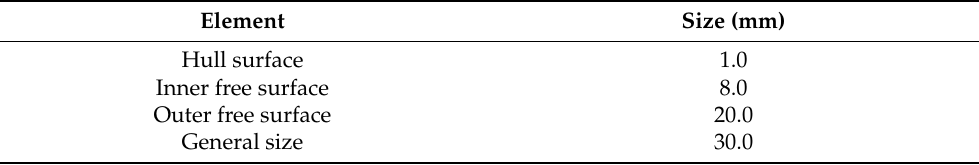
Figure 4. Mesh dependence analysis for bare hull resistance computations. Source: Own elabora- tion.